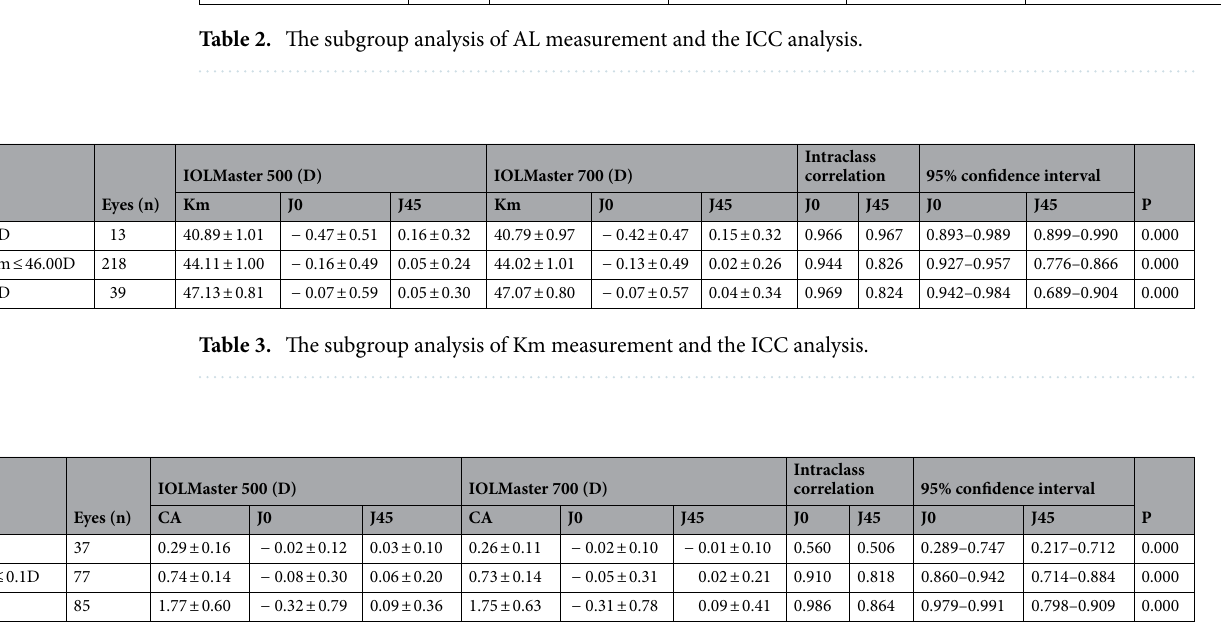
Table 2. The subgroup analysis of AL measurement and the ICC analysis.